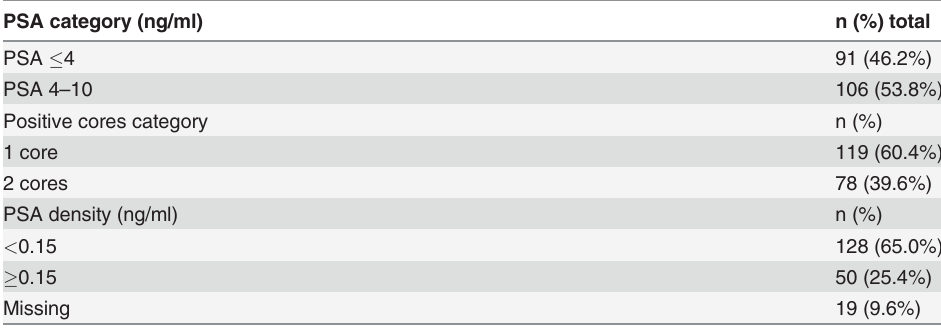
Table 3. Patient characteristics, Statistics: